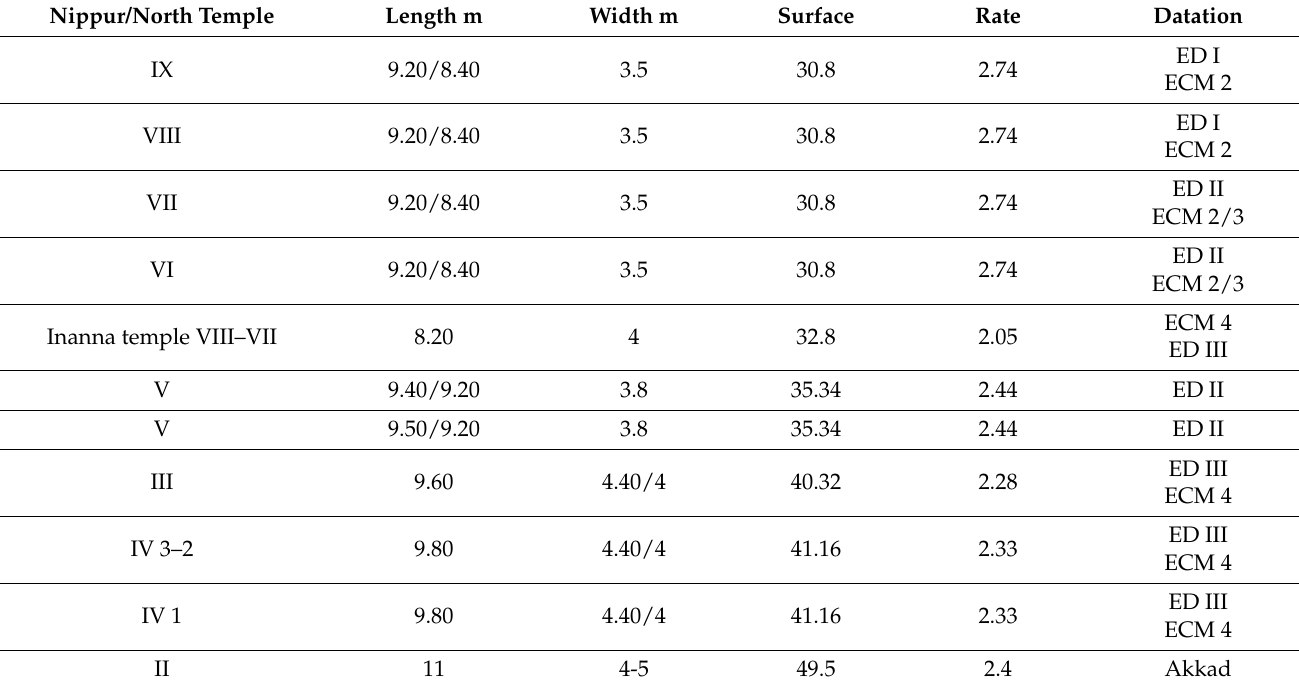
Table 3. Nippur, ceremonial rooms’ length and width, ordered by surface (two lengths are provided when the room is not